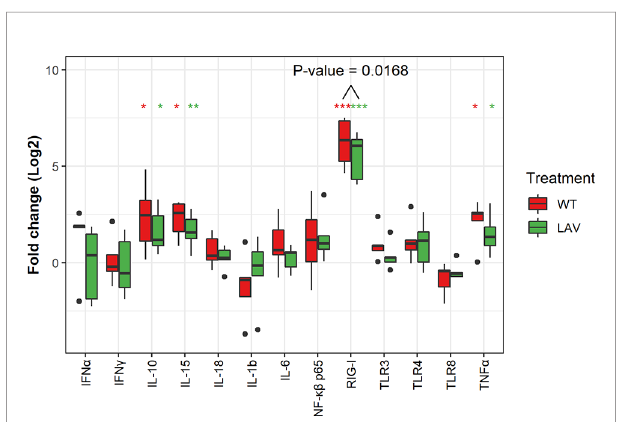
FIGURE 3 | Heat map for correlations of target genes expression FC using qPCR. The correlation heat map describes the combined Pearson correlation coef fi cient based on the distance between the two gene expression value against all target groups. This shows that the heatmap will cluster together, genes that have positively correlated log2 FC value, P-value; P<0.05*,